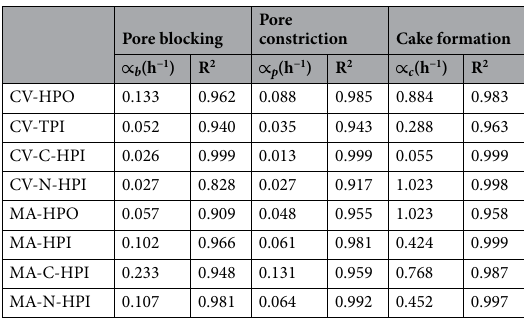
Pore blocking ∝ b (h −1 ) R